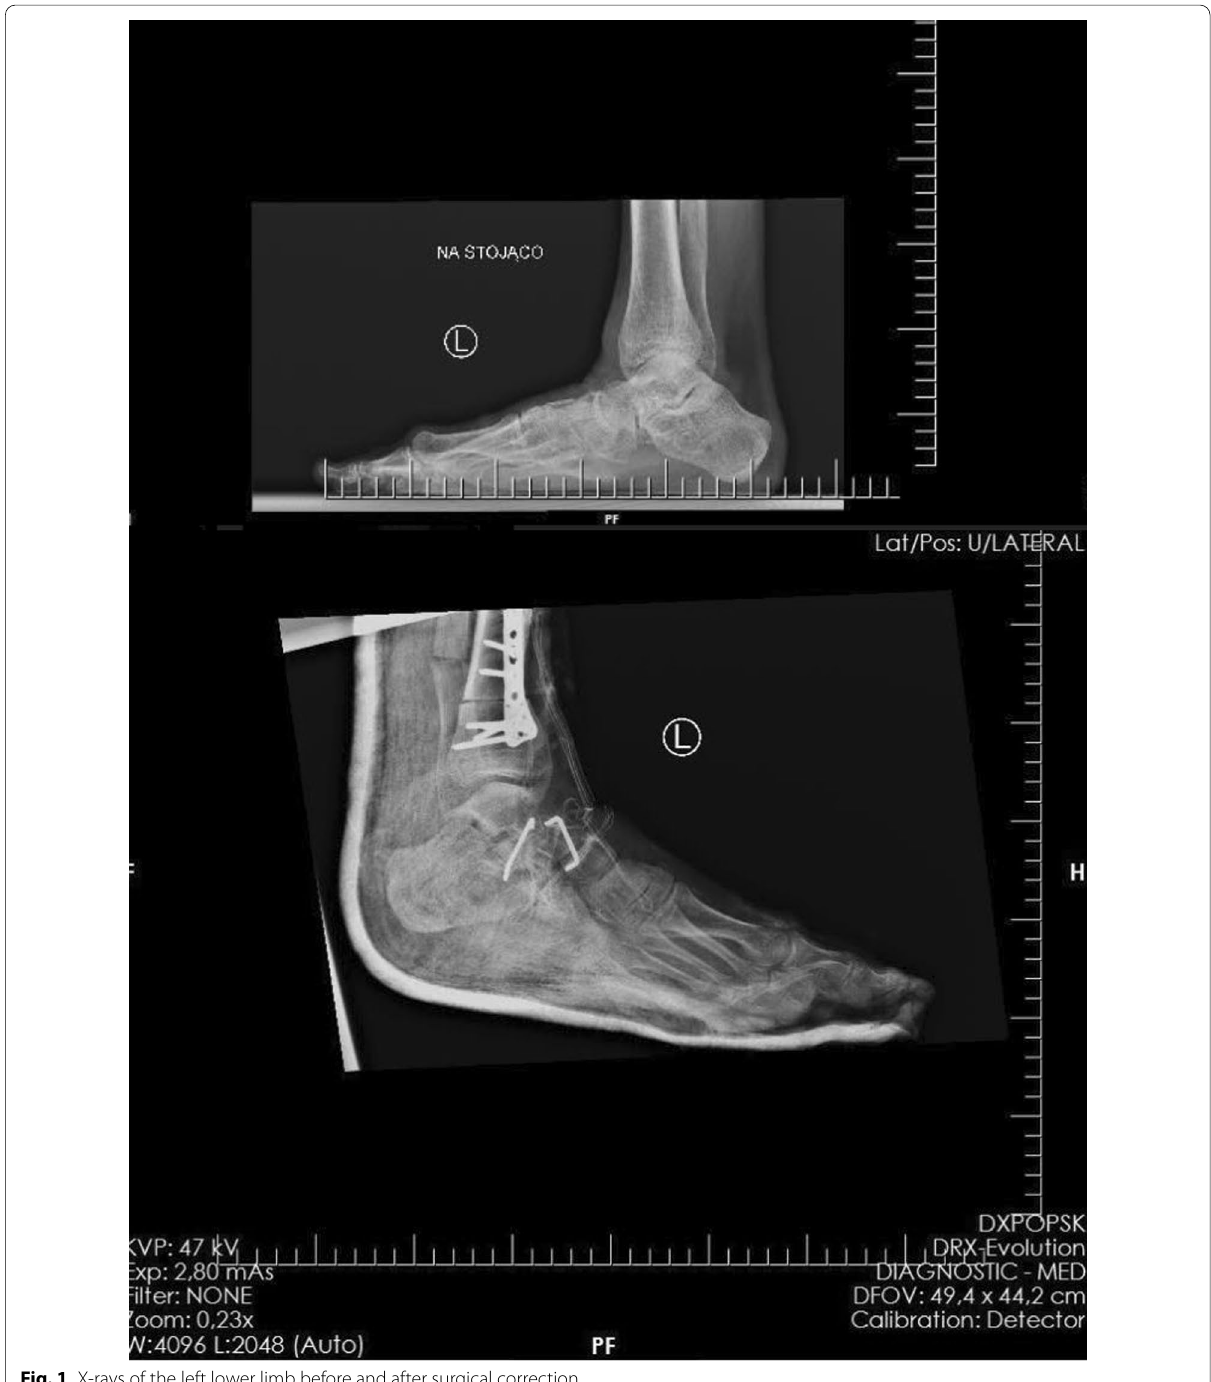
Fig. 1 X-rays of the left lower limb before and after surgical